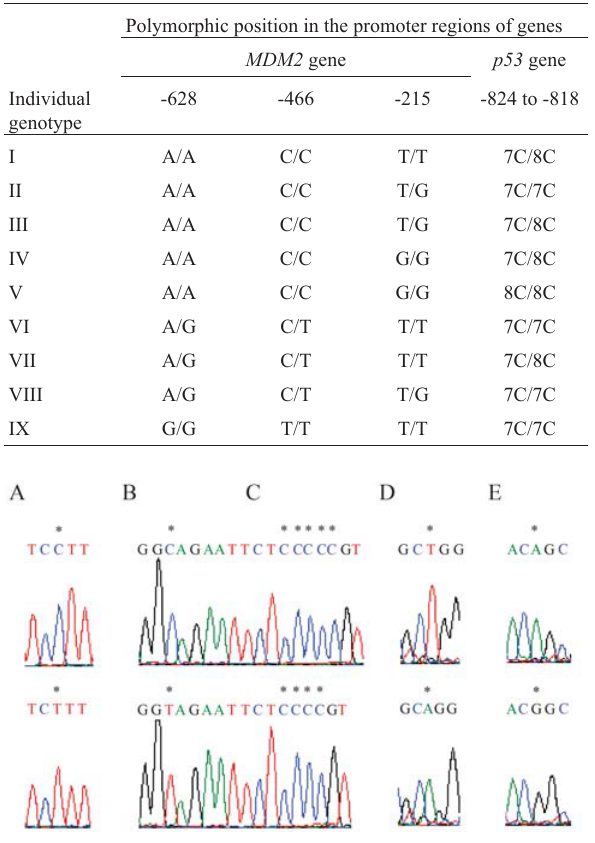
Table 4 - p53 promoter sequences in vector constructs. Table2 - MDM2 and p53 promoterpolymorphismsinnormalindividuals.